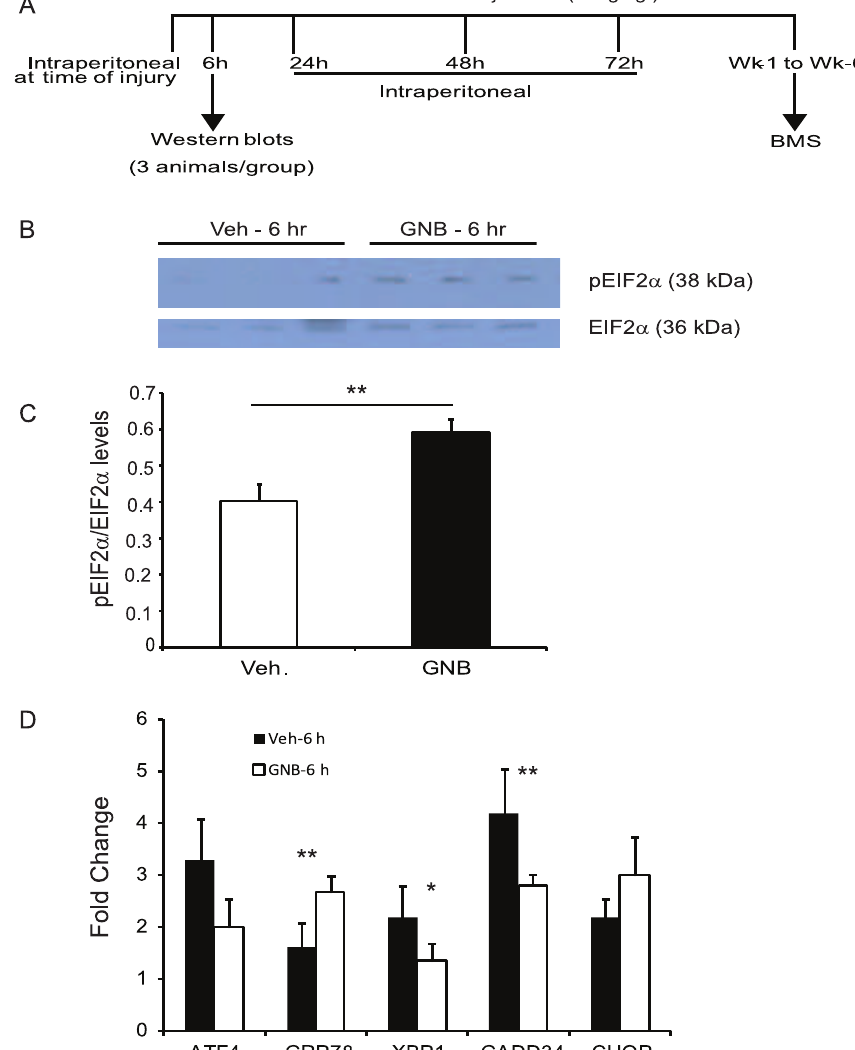
Figure 6. Invivo administration of guanabenz results in increased phosphorylation of eIF2 a and modulates the key ERSR markers 6 hours post-SCI. (A) Schematic representation of guanabenz injections given at various time points-post SCI. (B,C) Western blots show that guanabenz significantly increases phosphorylated eIF2 a levels at the injury epicenter of contused spinal cords. (D) Guanabenz leads to differential modulation in ERSR transcript levels as analyzed by qRT-PCR. Transcript levels are expressed as fold changes compared with respective levels in sham controls. Data are the mean 6 SD [n=3 (B,C); n=4 (D), * p , 0.05, **p , 0.01].